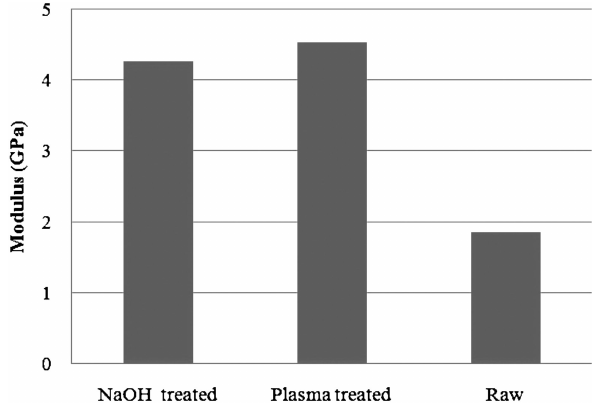
Figure 14: Comparison of modulus between untreated and NaOH and plasma treated RH